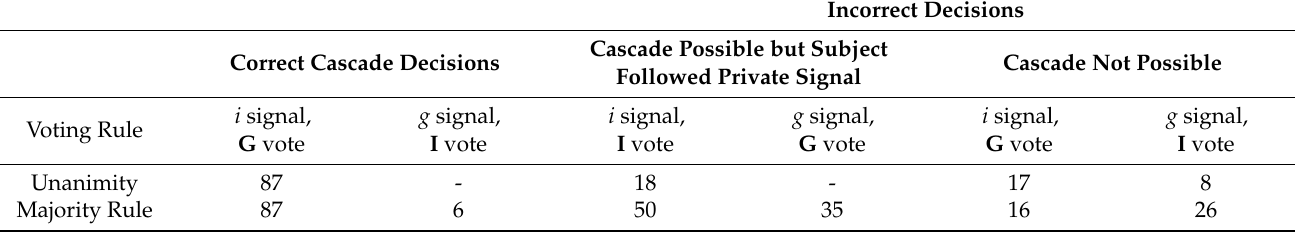
Table 4. Subject-level cascade